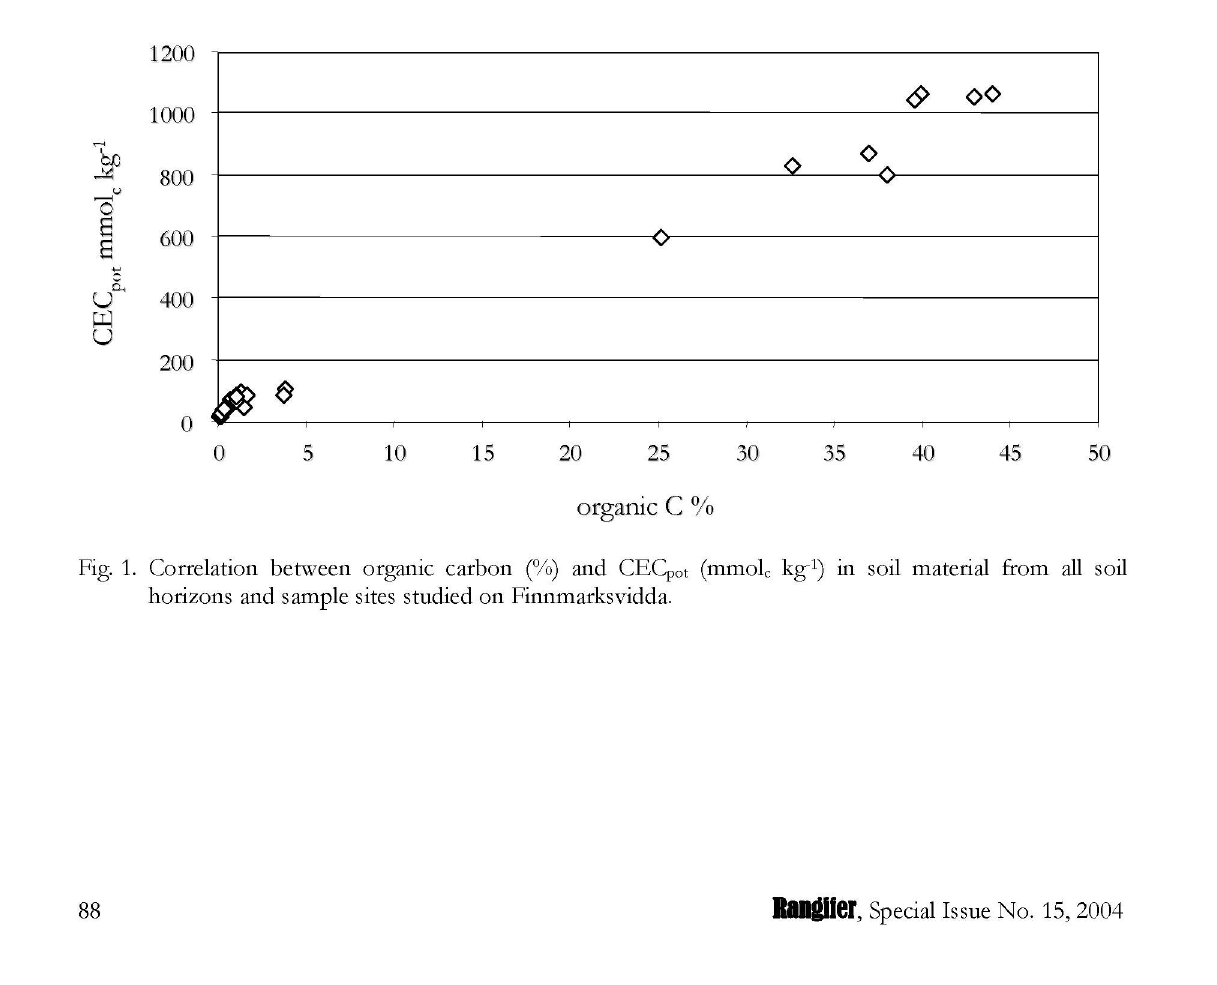
Fig. 1. Correlation between organic carbon (%) and CECpot (mmolc kg -1 ) in soil material from all soil horizons and sample sites studied on